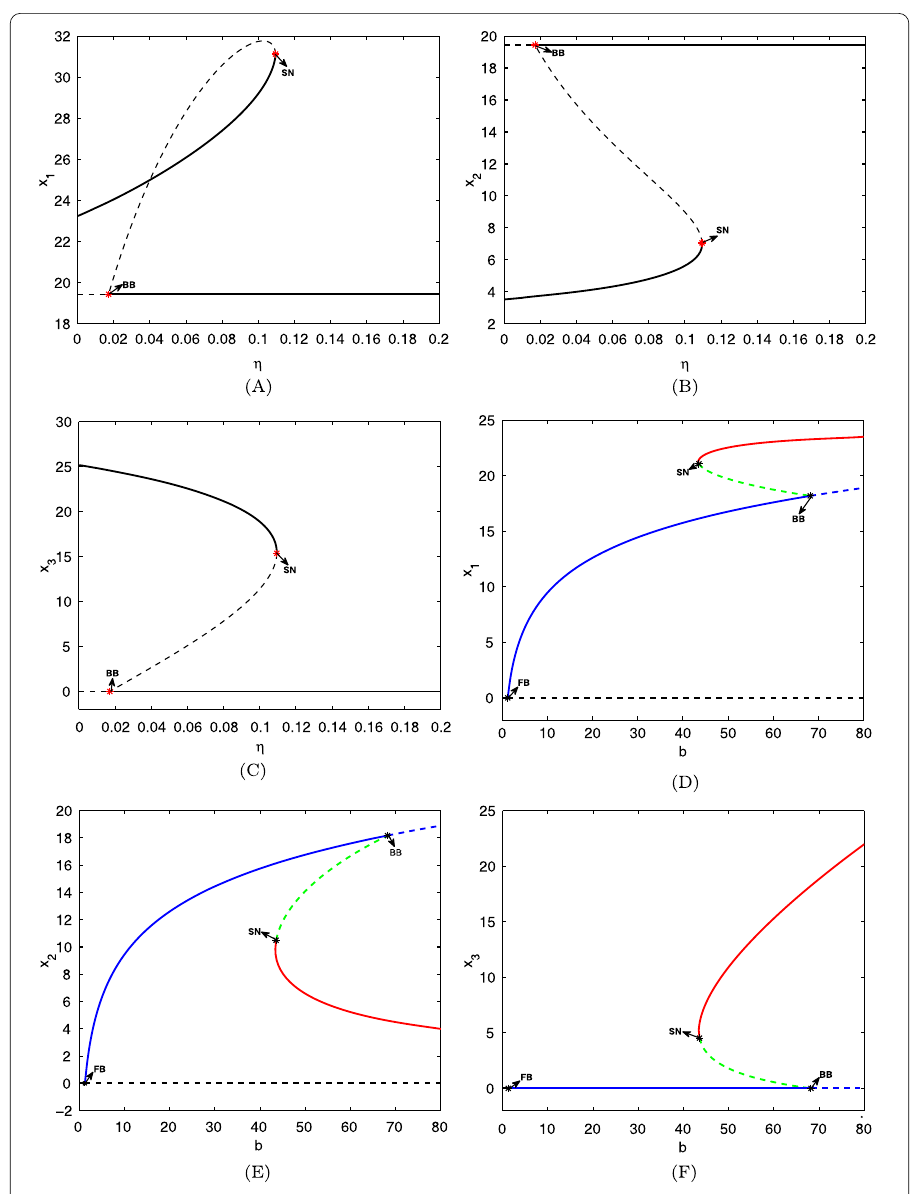
Figure 3 ( A )–( C ) One parameter bifurcation diagram with respect to η , here b = 90; ( D )–( F ) One parameter bifurcation diagram with respect to b , here η = 0.01. ‘SN’ represents saddle-node bifurcation, ‘BB’ means backward bifurcation and ‘FB’ is for forward bifurcation. Also, the dash curve is unstable equilibrium and the solid curve is the stable equilibrium. Here, δ = 2 and the other parameter values are the same as those in Fig.